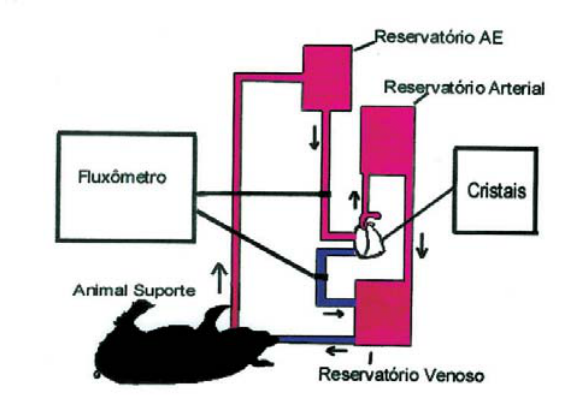
Fig. 1 - Coração isolado em modo de perfusão tipo “working heart”. O sangue era aspirado do animal suporte para o reservatório AE, que funcionava como pré-carga, e deste para o coração isolado, de onde era ejetado na aorta para o reservatório arterial. O sangue retornava para um reservatório venoso junto com o sangue efluente do seio coronário, drenado por cânula na artéria pulmonar. Deste reservatório era reinfundido no animal suporte. Variações de altura dos reservatórios AE e arterial correspondiam a variações, respectivamente, de pré e pós-carga. Sob monitorização pelas linhas de pressão no AE, na aorta, e no VE, pelos cristais piezoelétricos e pelos fluxômetros